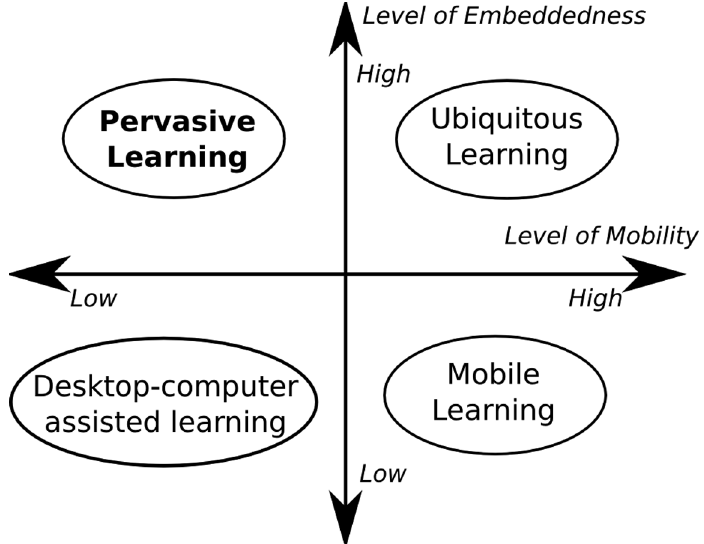
Figure 1. Types of learning. Source: Lyytinen and Yoo